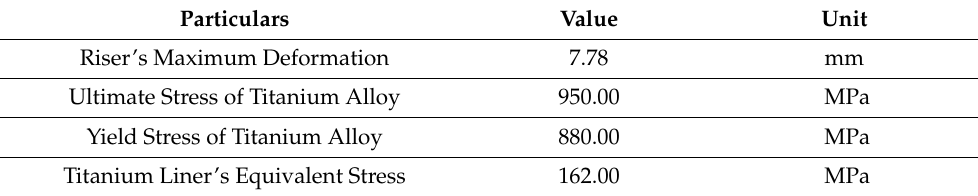
Figure 15. Stress profiles for the top, middle, and bottom lamina along the ( a ) fibre and ( b ) transverse directions under tension case. Table 10. Riser deformation and liner stress during tension event’s preliminary